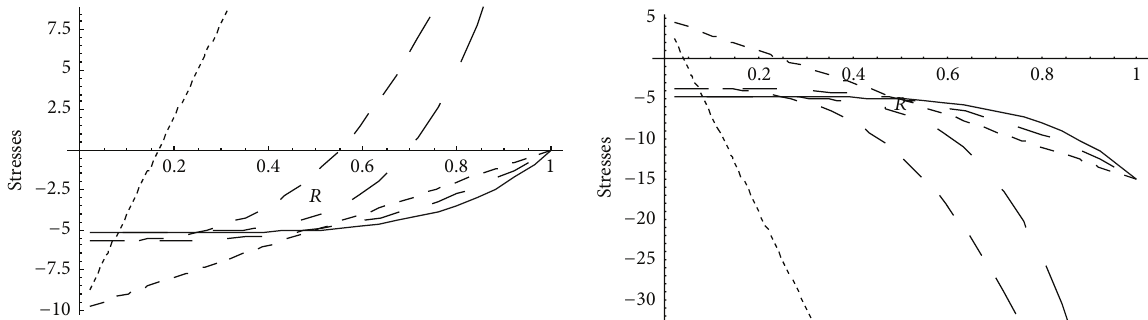
Figure 14: Nonhomogeneous fully plastic stresses for a thick-walled circular cylinder under internal ( 𝑃 1 = 5 ) and external pressure ( 𝑃 2 = 0 and